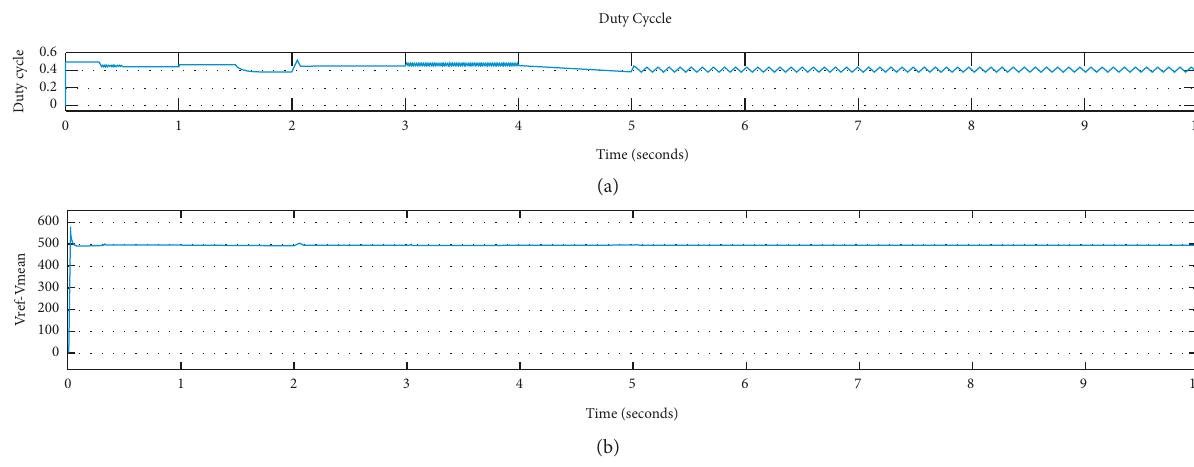
Figure 10: DC-DC boost converter: (a) duty cycle and (b) output voltage.